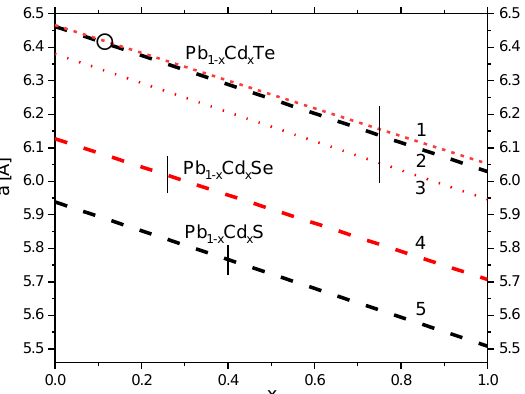
Figure 1. Reported variations of the metastable-rocksalt-phase lattice parameter of ternary Pb 1 − x Cd x Te, Pb 1 − x Cd x Se and Pb 1 − x Cd x S. The plots present the linear equations reported in ref. [18] (1), ref. [19] (2), ref. [7] (theoretical data) (3), ref. [20] (4), and ref. [25] (5). The highest values of Cd content in quenched samples among the reported ones, x max (see Table 1), are marked with short vertical solid lines. The variations are extended above the achieved (in quenched crystals) Cd content towards x = 1, in order to indicate the extrapolated lattice parameters of rocksalt structures of the binary Cd chalcogenides. The open circle indicates the composition of the Pb 1 − x Cd x Te sample studied in this work. Table 1. Linear equations for a ( x ) or V ( x ) (Vegard ’ s rule and Zen ’ s rule, respectively) for Pb 1 − x Cd x Te, Pb 1 − x Cd x Se and Pb 1 − x Cd x S solid solutions: equations, maximum reported Cd content, x max , and ex- trapolated lattice parameters, a ex , for rocksalt type CdTe, CdSe and CdS (at x = 1). Compound a ( x ) [Å] or V ( x ) [Å 3 ]